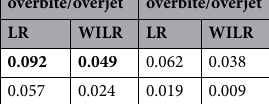
Speakers with overbite/overjet